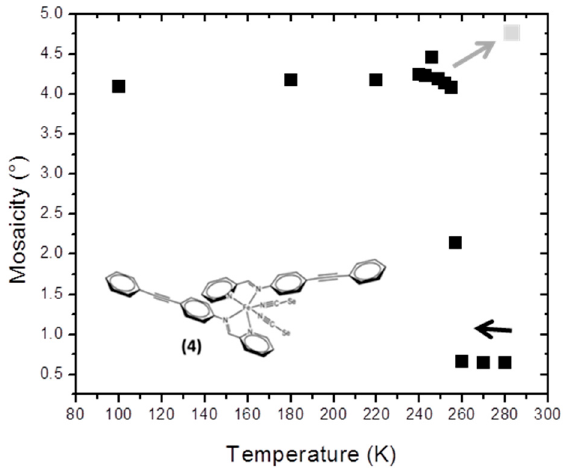
Figure 4. Temperature dependence of the mosaicity of [Fe(PM-PeA) 2 (NCSe) 2 ] in the cooling mode (black squares), including the return values (light grey) after warming at room temperature.